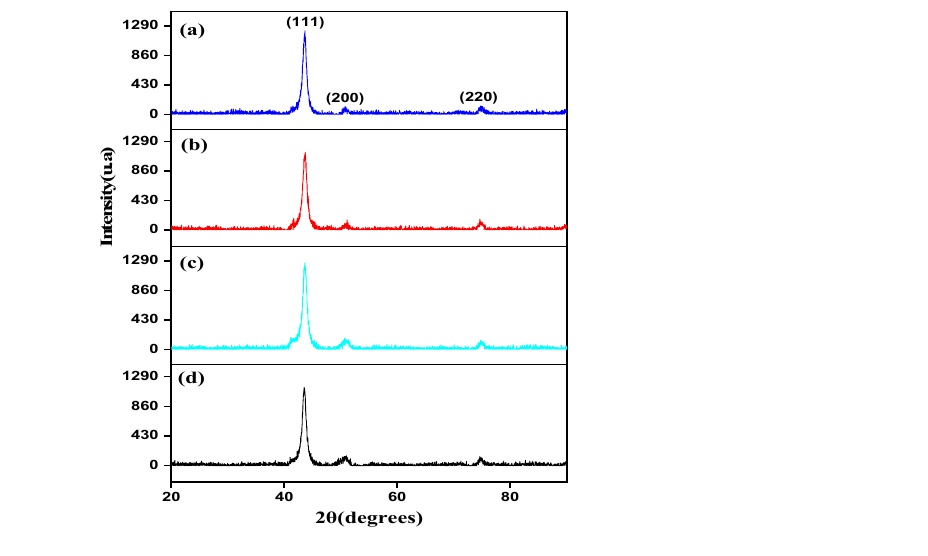
Figure 10. XRD patterns of Ni-W/SiC composite coatings on polished 45 steel obtained at different SiC concentrations: ( a ) 0 g L − 1 ; ( b ) 3 g L − 1 ; ( c ) 6 g L − 1 ; ( d ) 12 g L − 1 .